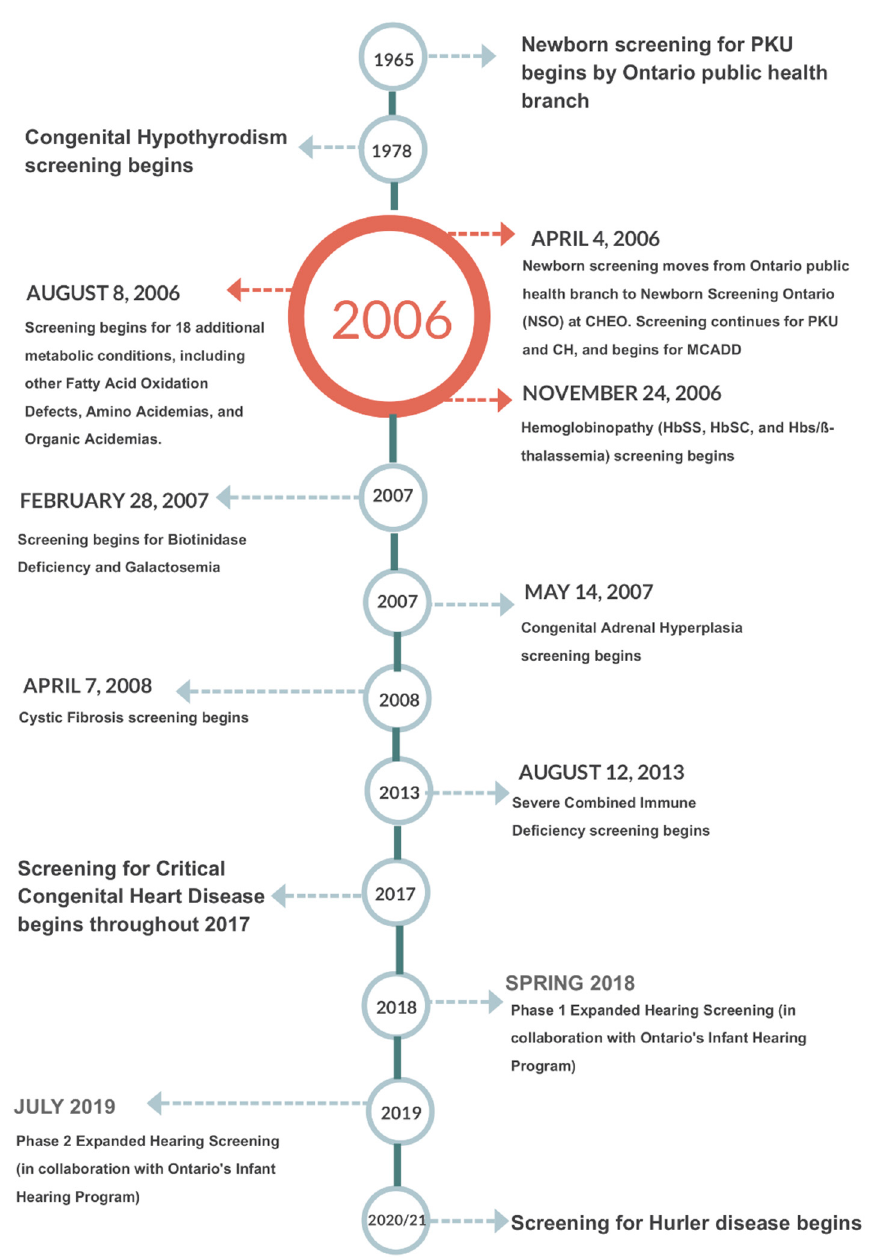
Figure 1. Newborn screening Ontario timeline.